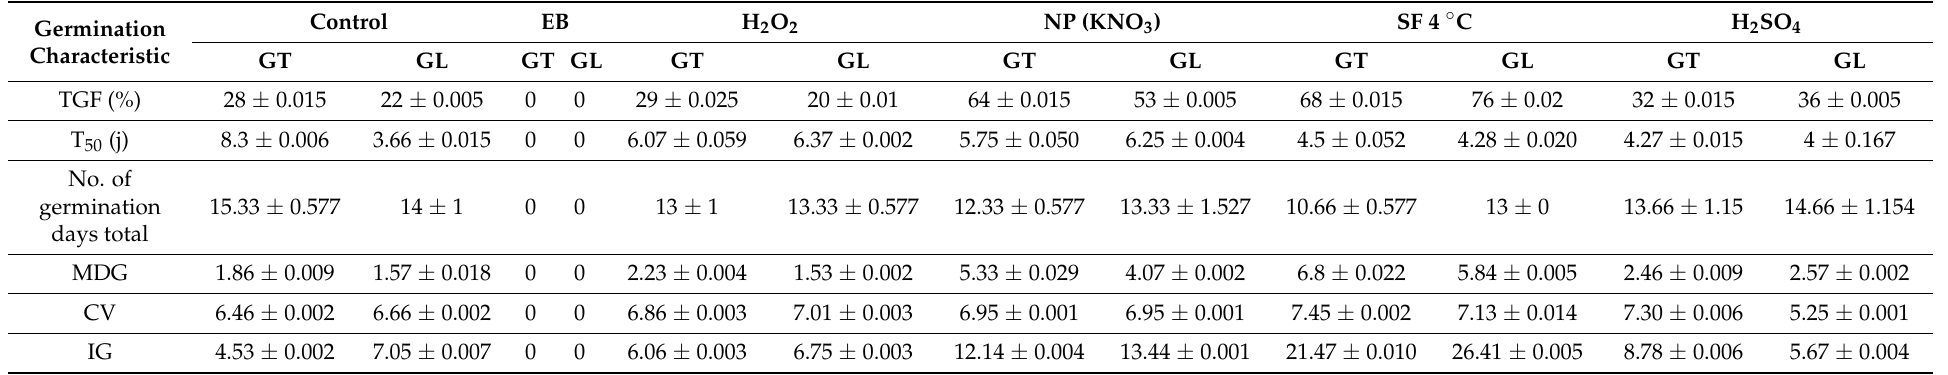
Table 4. Averages of the main germination parameters of A.P var. pyrethrum seeds (GL: peripheral seeds; GT: central seeds) in soil, according to the different pre-treatments (EB: boiling water, H 2 O 2 oxygenated water, NP: potassium nitrate; SF 4 ◦ C: cold scarification 4 ◦ C; H 2 SO 4 : sulphuric